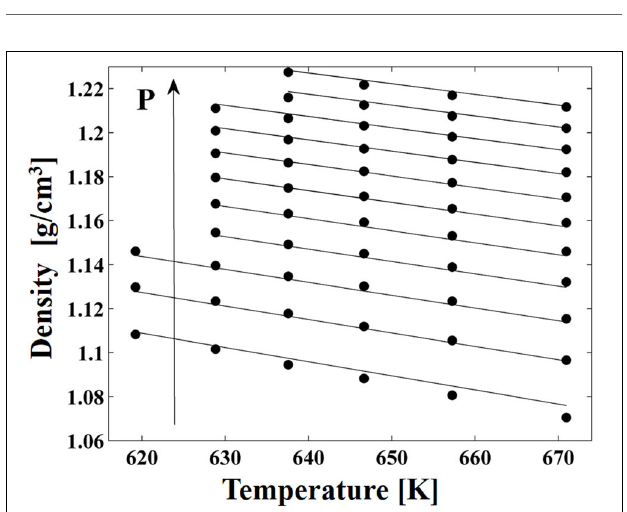
FIGURE 3 | PVT data of PEEK from Zoller and Walsh (1995), full circles. Lines represents fitting results by using NRHB model.